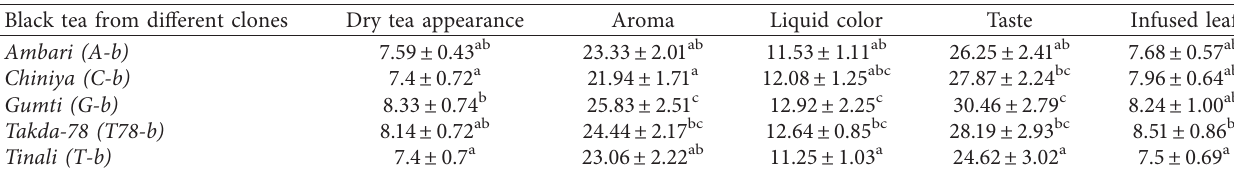
Table 5: Sensory attributes of black tea prepared from different clones of tea plants. Black tea from different clones